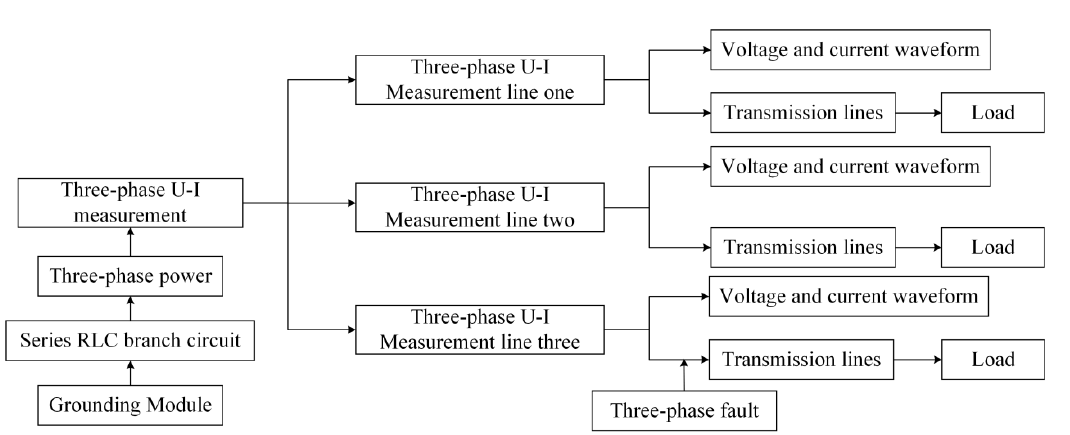
Figure 3. BAS-BP algorithm flow chart.